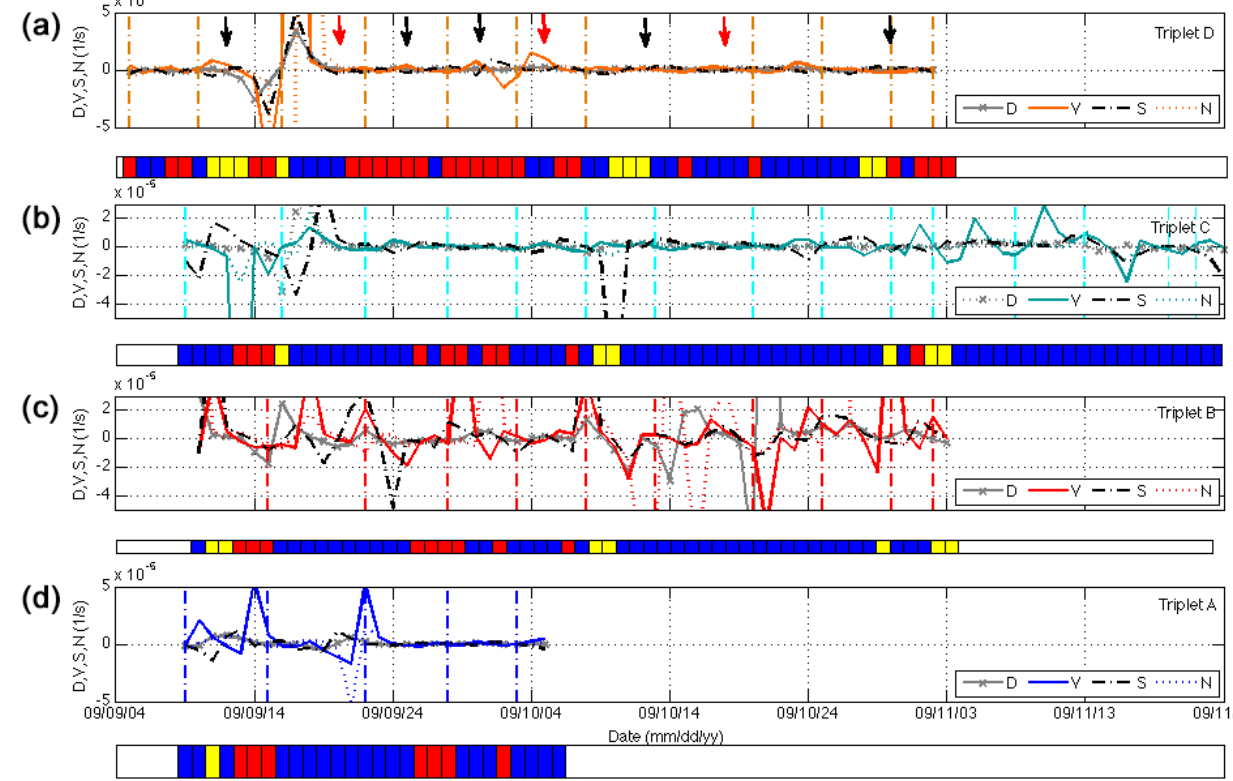
Figure 11. Sea ice deformation. Time series of differential kinematic parameters (DKPs) divergence ( D ), vorticity ( V ), the shearing deforma- tion rate ( S ), and the normal (stretching) deformation rate ( N ) for triplets A (d) to D (a) . Vertical lines depict SLP high in the vicinity of each triplet centroid as shown in Fig. 3. Horizontal bar graphs depict on-, along, and offshore ice drift as depicted in Fig. 6. For triplet A, located closest to the coastline, sea ice deformation is characterized predominantly by vorticity and stretching. Triplet B is governed by vorticity for the duration of this triplet evolution, with contributions from shear until 8–10 October and divergence and stretching following mid-October. Triplet C, located further from the coastline, is characterized by vorticity in the early and late stages of triplet evolution, with intermittent contributions from shear and to a lesser extent divergence during low ice concentration regimes. Triplet C also experiences enhanced vorticity following the 8 October SLP high. A strong shear event is in addition observed for triplet B during the SLP high on 8 October and for triplet C on 10 October. Located furthest from the coastline, triplet D is governed by vorticity, stretching, shear, and divergence in the early stages of development and by vorticity and to a lesser extent shear for the duration of the triplet